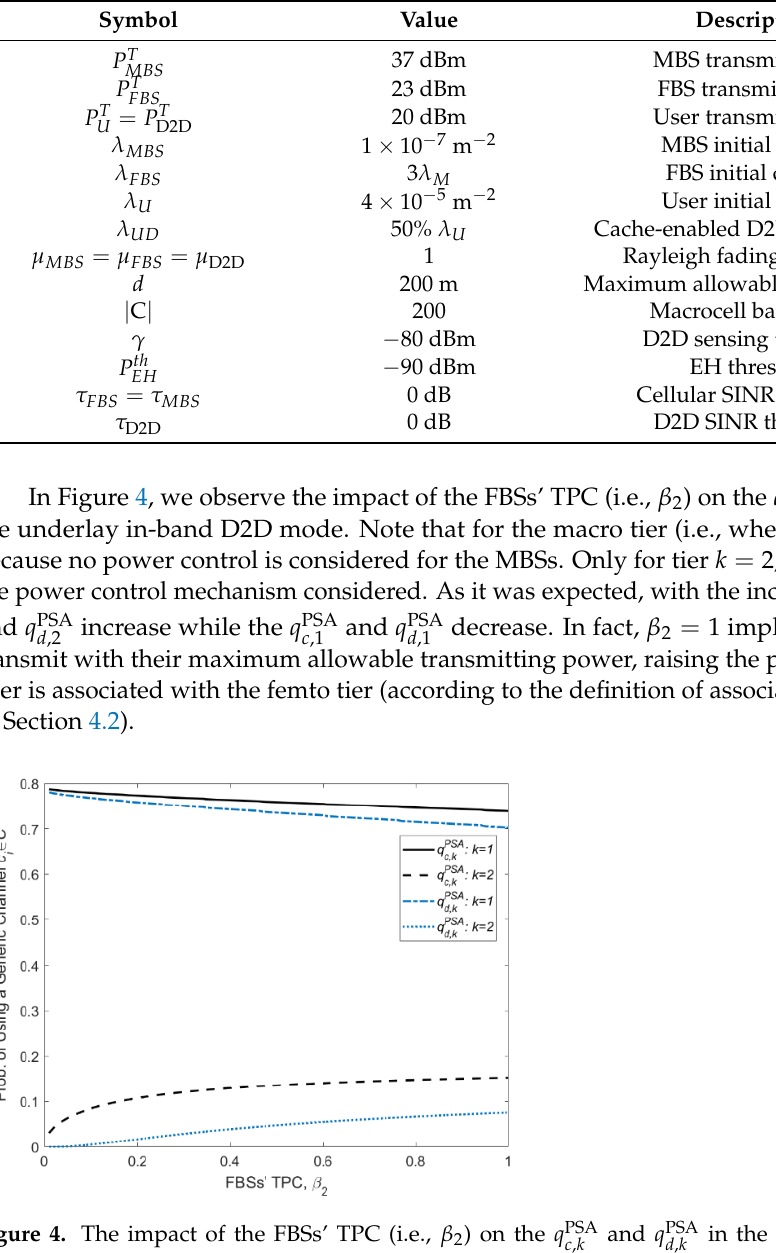
Table 1. Major simulation parameters.